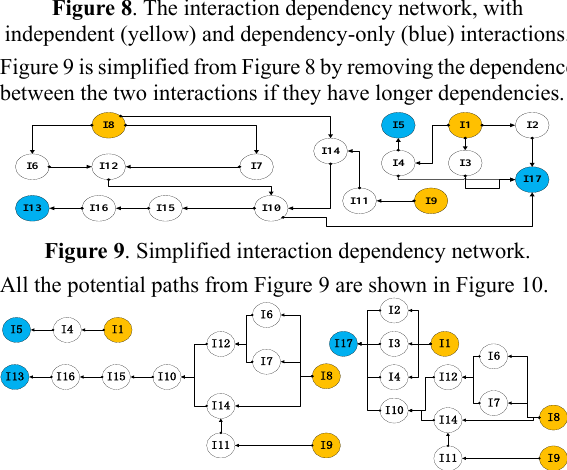
Figure 10 . Paths in simplified interaction dependency network.